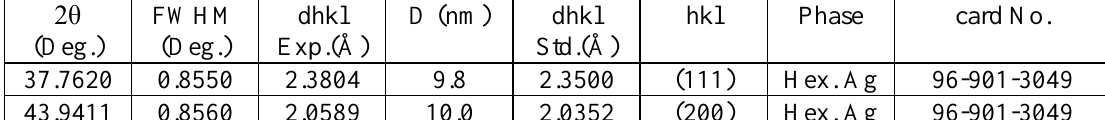
Fig. 4: XRD pattern for Ag nanoparticles sprayed on glass substrates. Table 2: XRD peaks for titanium oxide (Ag) nanoparticles.